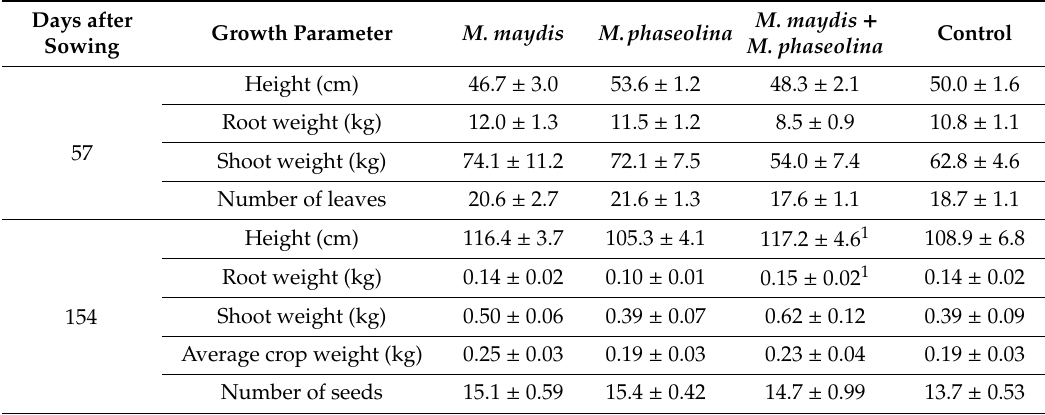
Table 7. Cotton average growth indices at 57 DAS (at flowering) and at 154 DAS (at harvest) as a result of infection with M. maydis and M. phaseolina (the 2018 experiment).